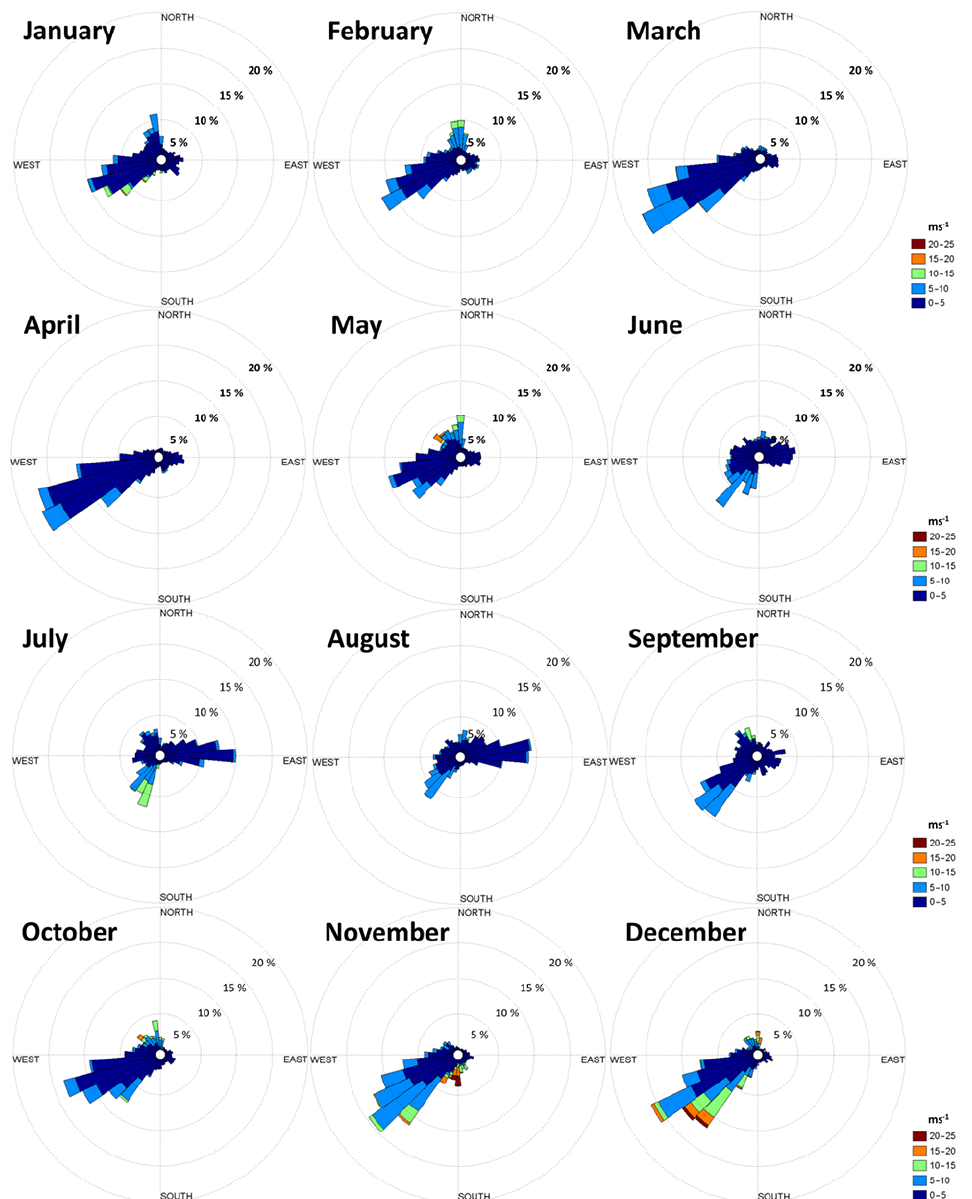
Figure 5. Wind roses showing monthly wind direction and wind speed at Station Nord during 2012. The concentric rings show the percentage of wind arriving from a particular